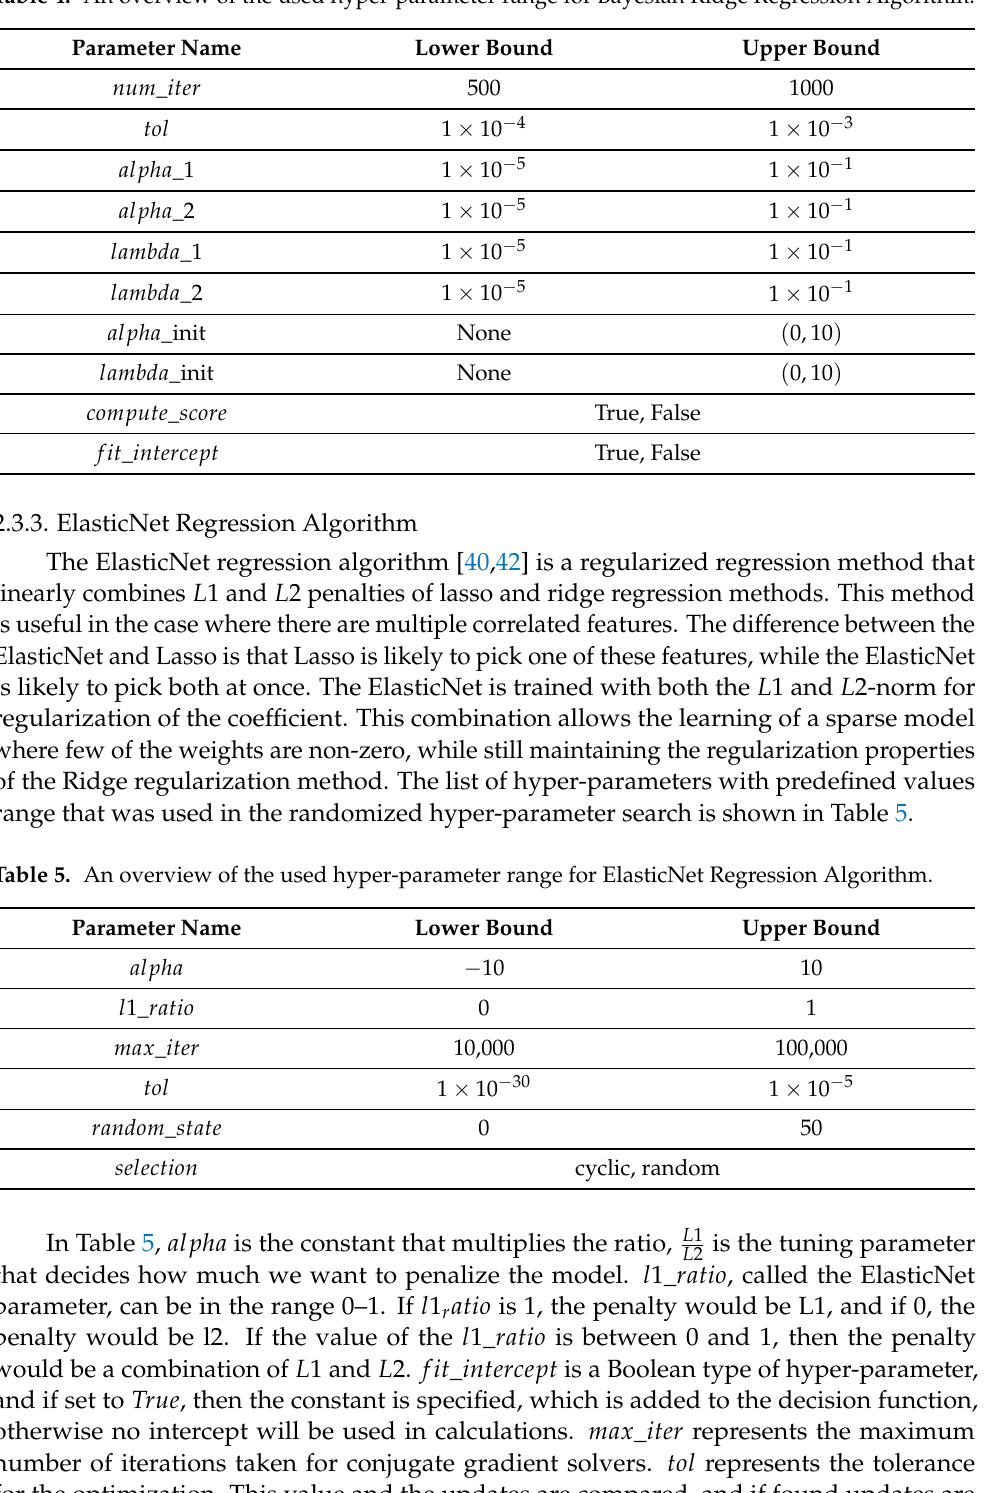
Table 4. An overview of the used hyper-parameter range for Bayesian Ridge Regression Algorithm.